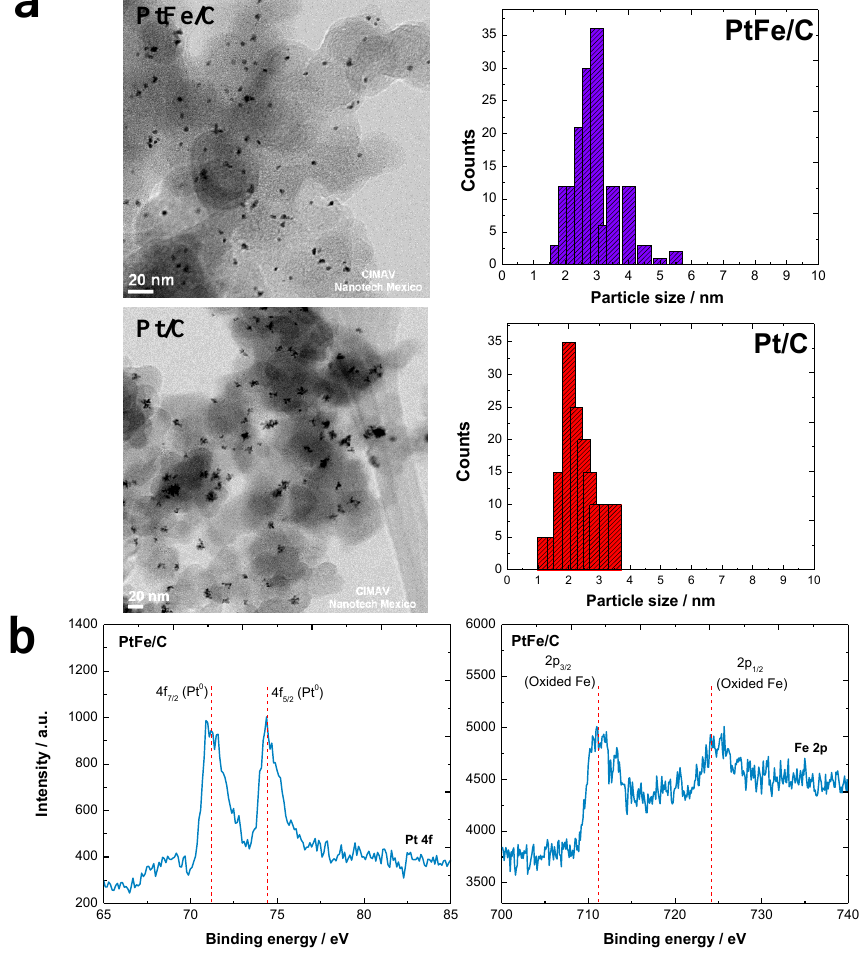
Figure 2. ( a ) HR-TEM micrographs of Pt/C and PtFe/C and particle distribution; ( b ) XPS spectra of Fe 2p and Pt 4f regions of the PtFe/C catalyst.